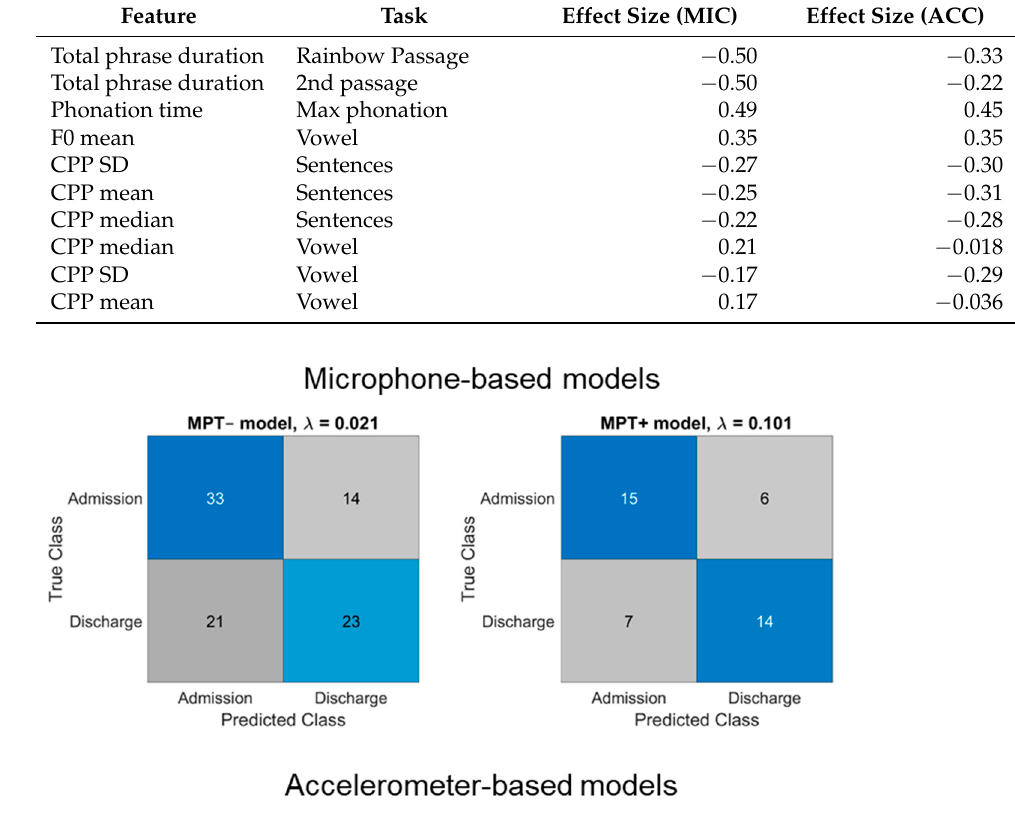
Table 1. Effect size (paired Cohen’s d) for selected features computed from the acoustic microphone (MIC) and neck-surface accelerometer (ACC) from the given speech tasks, sorted in decreasing order of MIC-based effect size magnitude.